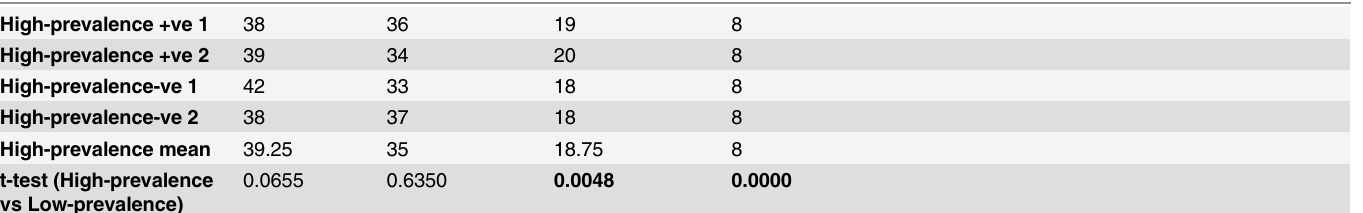
Cymbopogon sp. Hyptis sp. * 0 – 70